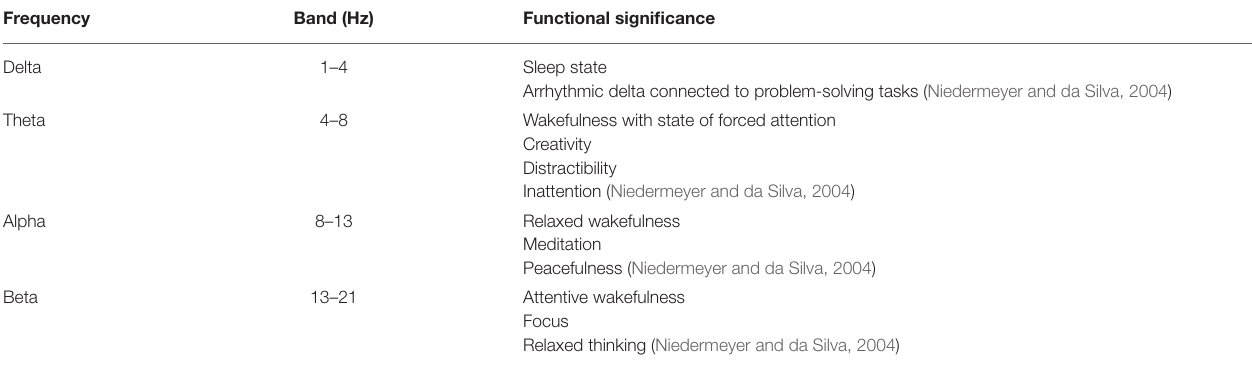
TABLE 2 | Frequency bands and associated cognitive